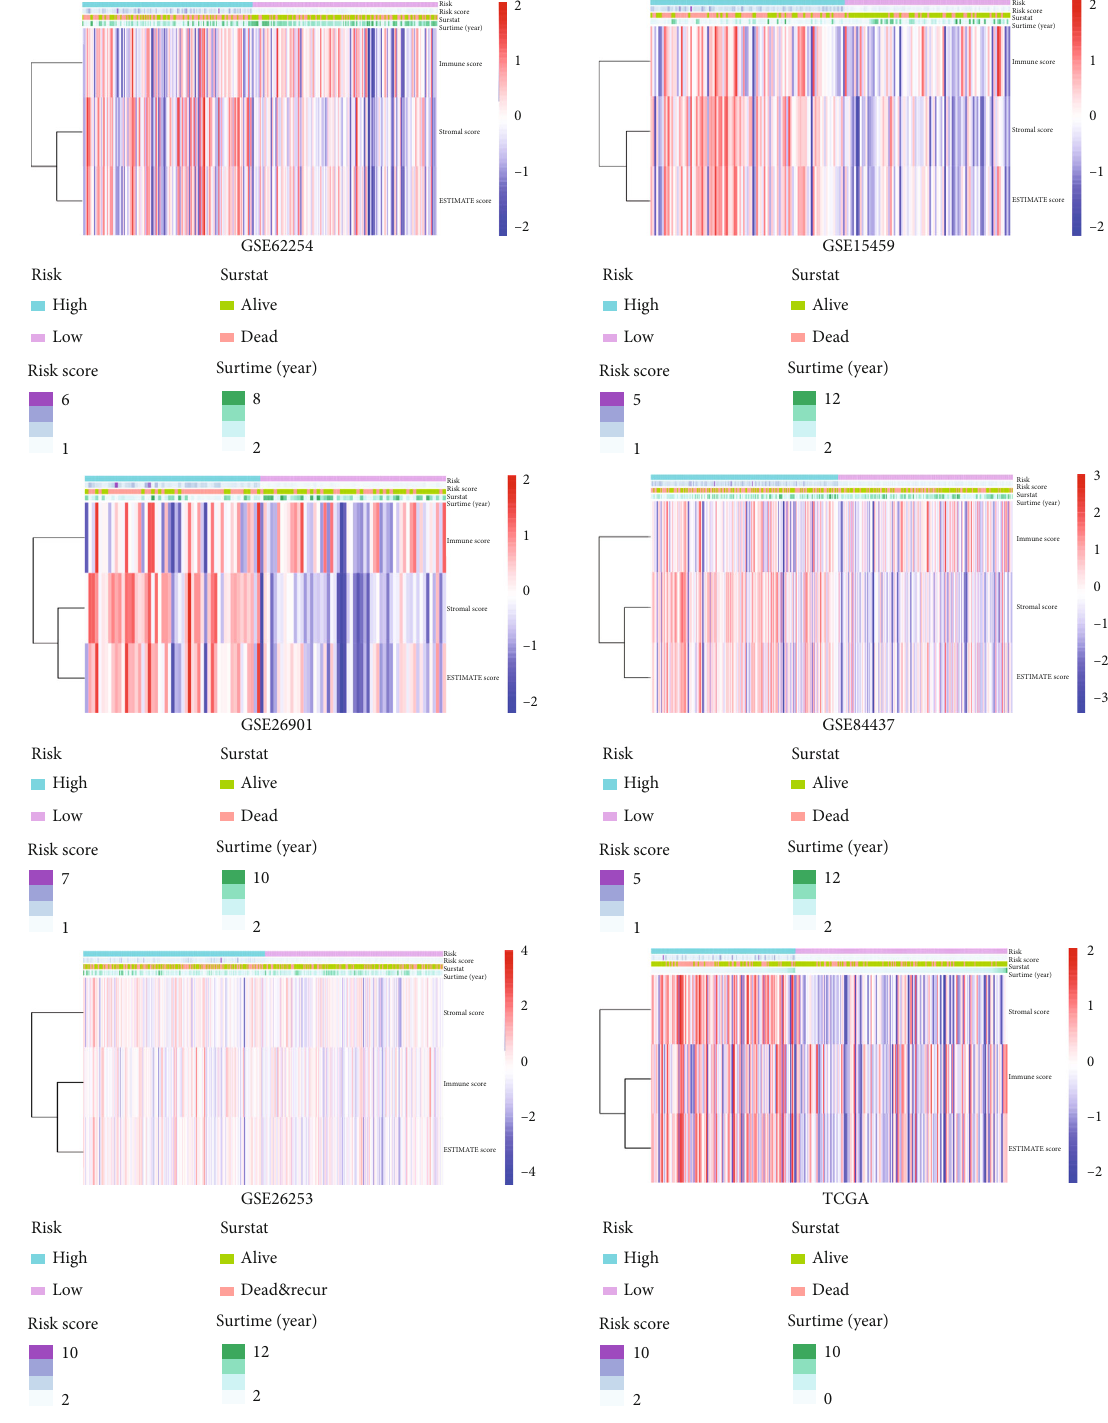
Figure 9: The presentation of ESTIMATE calculation